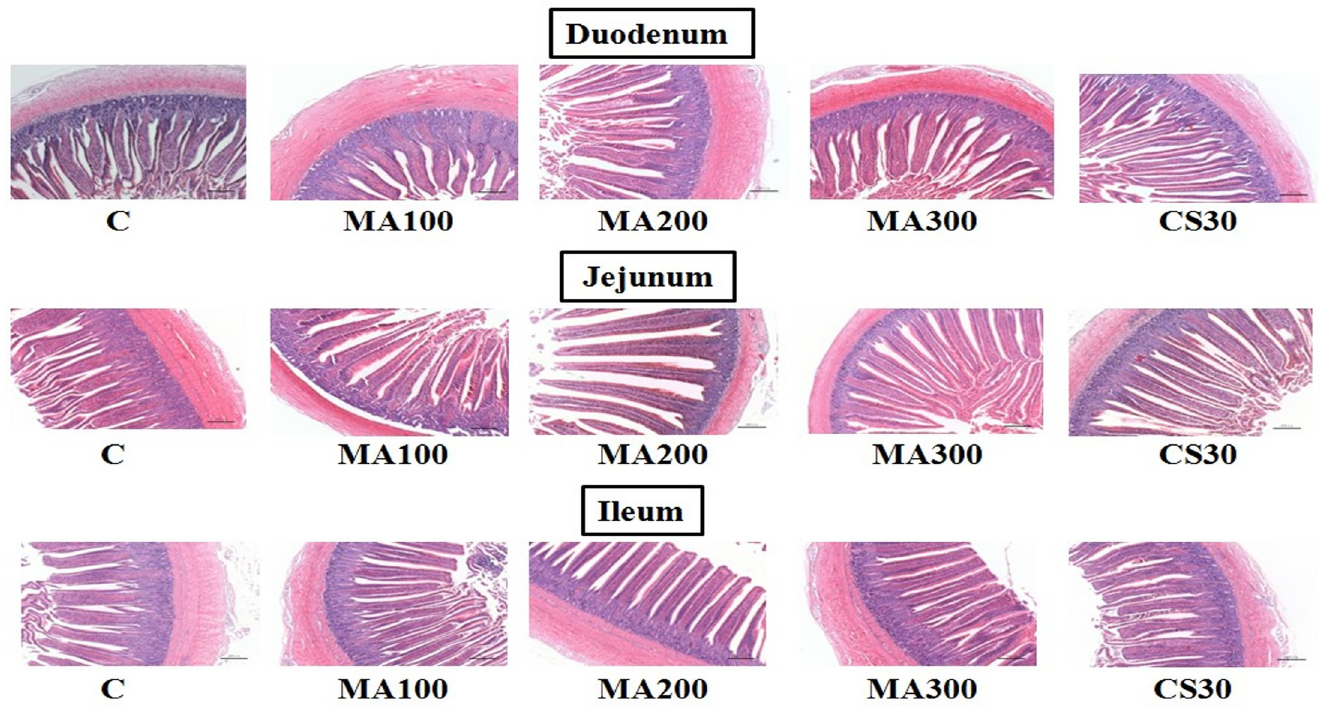
Fig 1. Effect of dietary magnolol at different levels on the intestinal mucosal morphology of 28 d Linwu ducklings (40 × ). C: control, basal diet; MA100: basal diet + 100 mg magnolol additive/kg diet; MA200: basal diet + 200 mg magnolol additive/kg diet; MA300: basal diet + 300 mg magnolol additive/kg diet; CS30: basal diet + 30 mg antibiotic additive/kg diet.